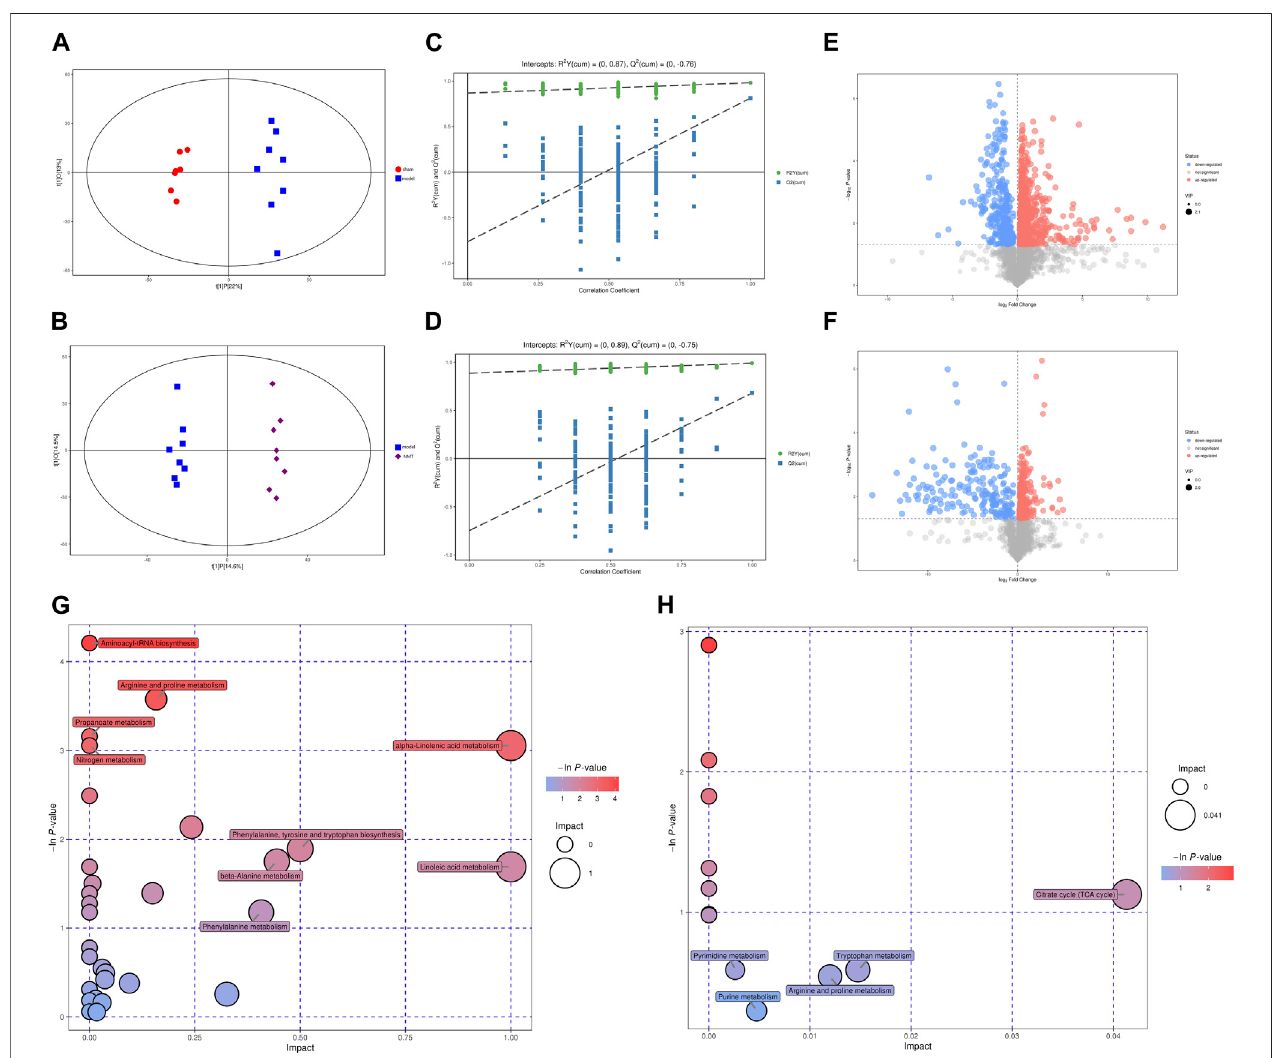
FIGURE 5 | The signi fi cant changes in metabolic pro fi les of gut microbiota in stroke and recovered rats. (A) The plots of OPLS-DA scores of all peak features in negative (ES-) ion modes from the untargeted metabolomics analysis of stool samples of the rats in sham ( n (cid:1) 7) and model ( n (cid:1) 8) groups; (B) The plots of OPLS-DA scoresofallpeak features innegative(ES-)ionmodesoftheratsinmodel ( n (cid:1) 8)andNMT( n (cid:1) 8)groups; (C) Negativescatter plotsofthestatisticalvalidations obtained by 200X permutation tests in sham ( n (cid:1) 7) and model ( n (cid:1) 8) groups. R2 measures the goodness of fi t and Q2 measures the predictive ability of the model. The criterionfor modelvalidityisthattheregression lineofthe Q2-points(bluedotted line)intersects thevertical solidline(ontheleft) belowzero; (D) Negativescatter plotsof in model ( n (cid:1) 8) and NMT( n (cid:1) 8) groups; (E) Negative volcano plot; volcano plotsofthe peak featuresofintestinal metabolites which signi fi cantly changed in three group in negative ionmode (ES-,upper panel).Red andblue circles indicate thesigni fi cantlyincreasedand decreased metabolites, respectively, (VIP > 1, p < 0.05) inmodelVS shamgroup.Thecolortoneindicates p value:adarkcolorindicatesasmall p value.ThecircleradiusindicatestheVIPvalueofcorrespondingpeakfeatures. (F) Negative volcano plot in model VS NMT group; (G) Bubble plot of important metabolic pathways for model VS sham group, as identi fi ed using KEGG pathway enrichment analysis; The size of the circle represents the impact factor obtained by topological analysis, the color tone indicates ln p value; (H) Bubble plot of important metabolic pathways for model VS NMT